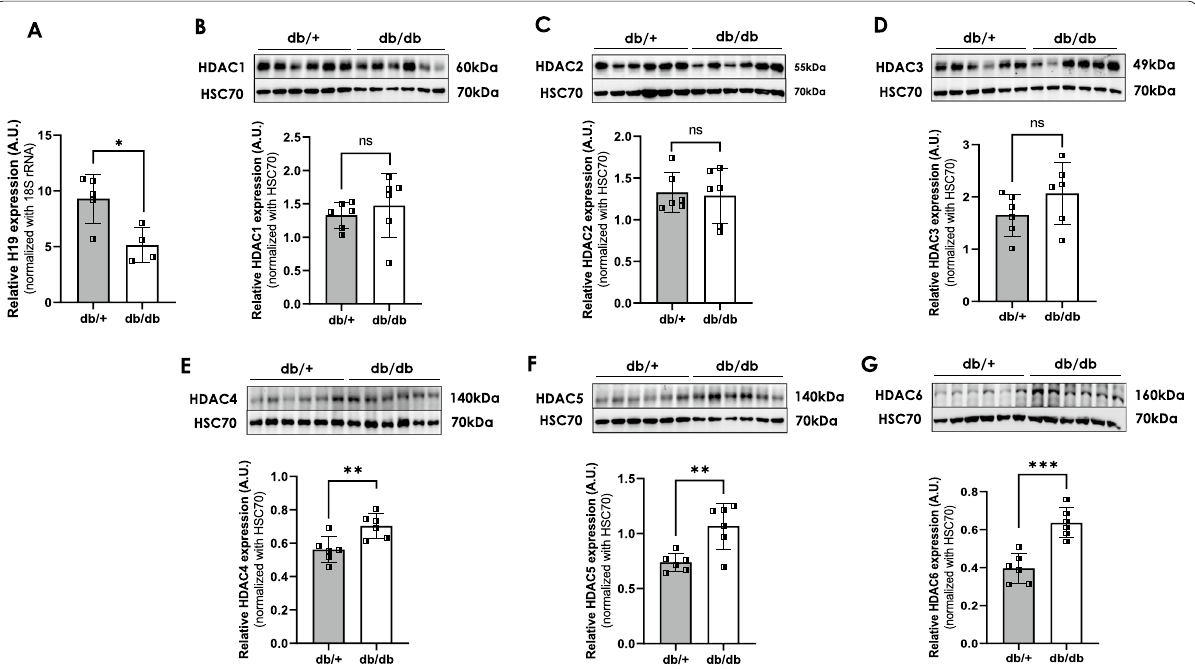
Fig. 1 Expression of lncRNA H19 and HDACs in db/db mice skeletal muscle. A Total RNA was isolated from the skeletal muscle of normal (db/ ) + and diabetic (db/db) mice and 1 µg RNA was reverse transcribed and subjected to qRT-PCR to assess the transcript levels of the lncRNA H19. 18S rRNA was used as the loading control. Skeletal muscle of normal (db/ ) and diabetic (db/db) mice were lysed as described in the “Material and + methods” section and 20–30 µg lysates were run on SDS-PAGE and the levels of HDAC 1–6 were evaluated by Western Blot analysis. HSC70 was used as the loading control. Densitometric analyses of the expression are shown in the panel below ( B – G ). All experiments were performed in at least four animals in each group, values are